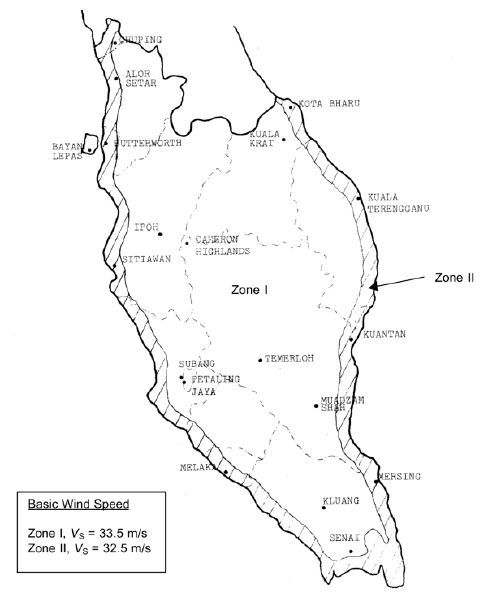
Figure 2. Basic wind speed of Malaysia [3].